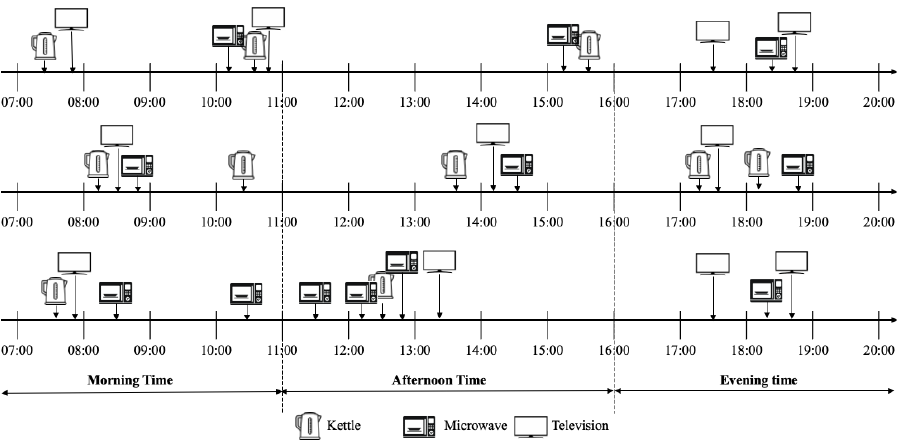
Figure 5. The daily activities of house 4 from 11 October 2013 to 13 October 2013.